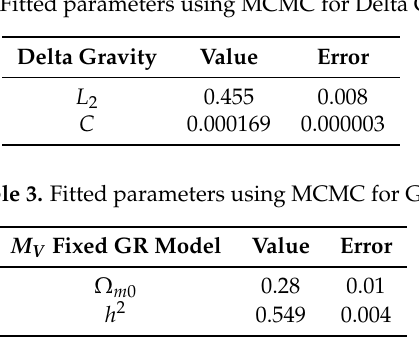
Table 2. Fitted parameters using MCMC for Delta Gravity.